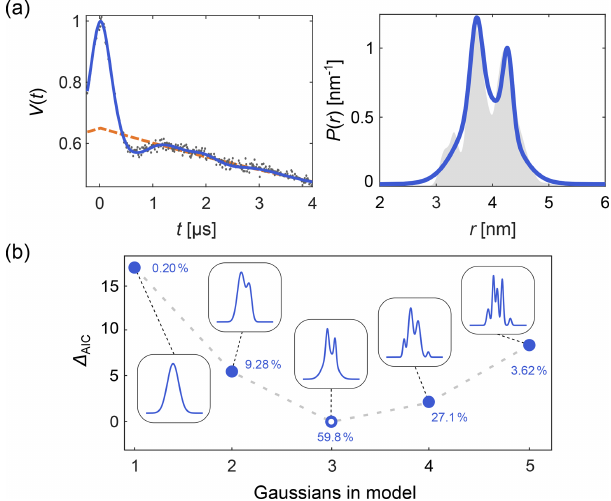
Figure 2. Time-domain multi-Gauss fitting of a simulated four- pulse DEER signal. (a) The data are given as grey dots, the ground truth distance distribution as a shaded area, and the corresponding fits of a 3-Gauss model as blue lines. The background fit is given as dashed orange line. (b) The difference in AIC values as a function of the number of Gaussians is shown in blue, and the correspond- ing fits are given in the insets. The differences (cid:49) AIC are relative to the model with the lowest AIC value. The corresponding Akaike weights (see Sect. 10) are given next to each model. The model with the lowest AIC value (i.e., largest Akaike weight) is selected as the optimal